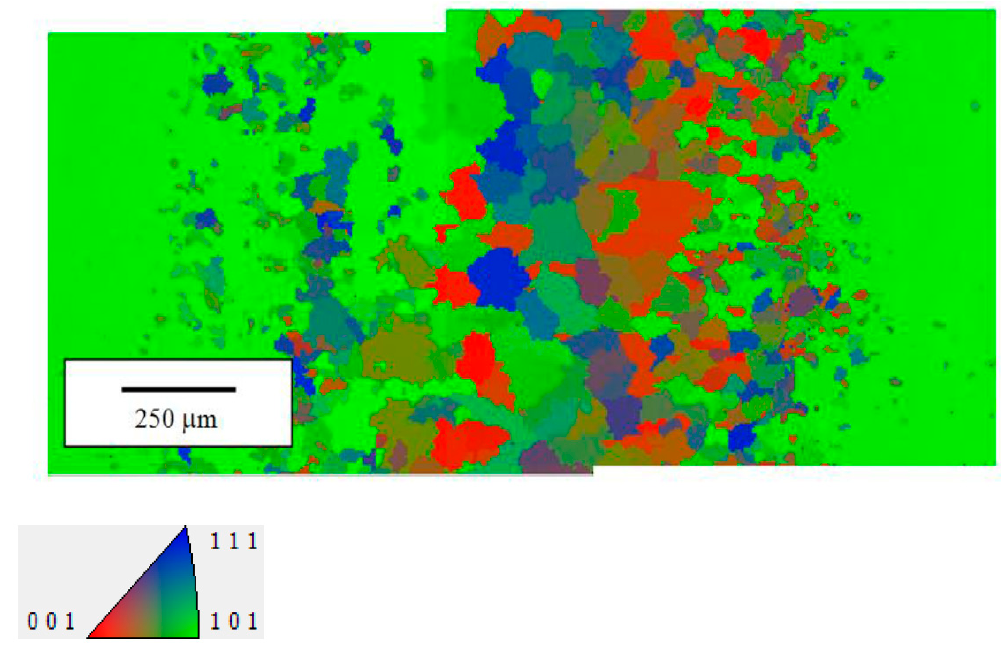
Figure 14. Example for EBSD map collected from a joint realized with PHT = 300 °C and pass speed v = 2.0 m/min after PWHTs of 2 h at 700 °C.